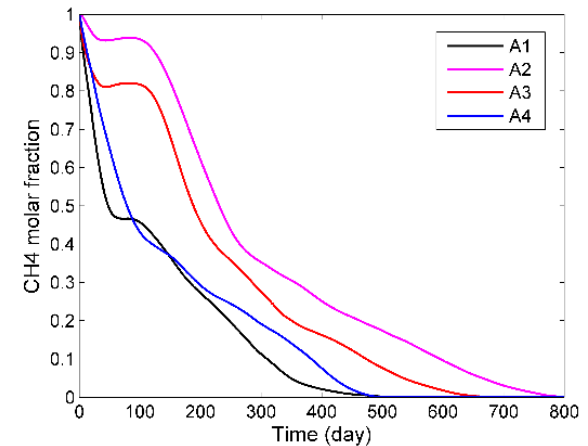
Figure 22. Comparison of injector BHP for CO 2 -ECBM and N 2 -CO 2 -ECBM.